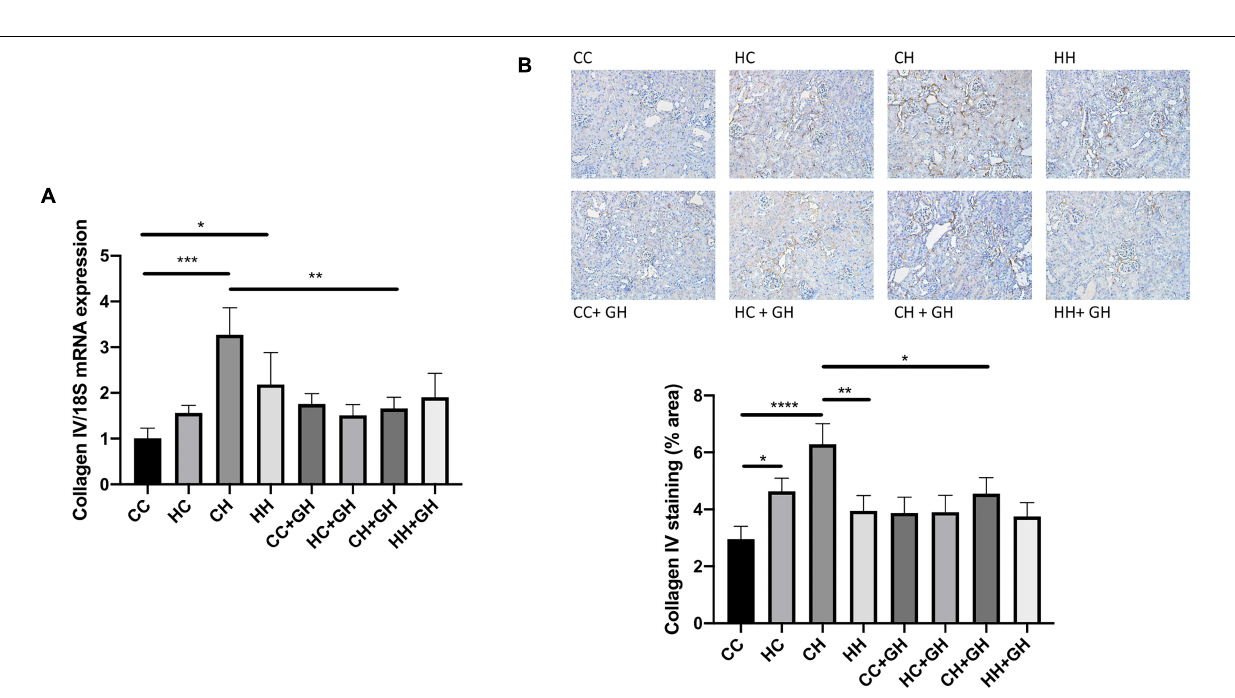
Frontiers in Cell and Developmental Biology |